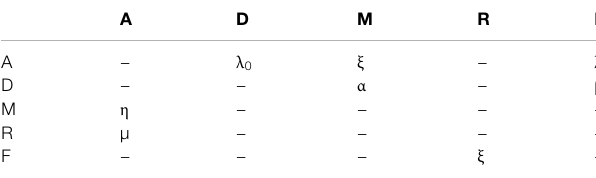
TABLE 2 | Transition rates used in the Markov models.